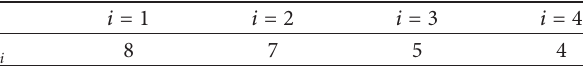
Table 3: Work hours of employees.